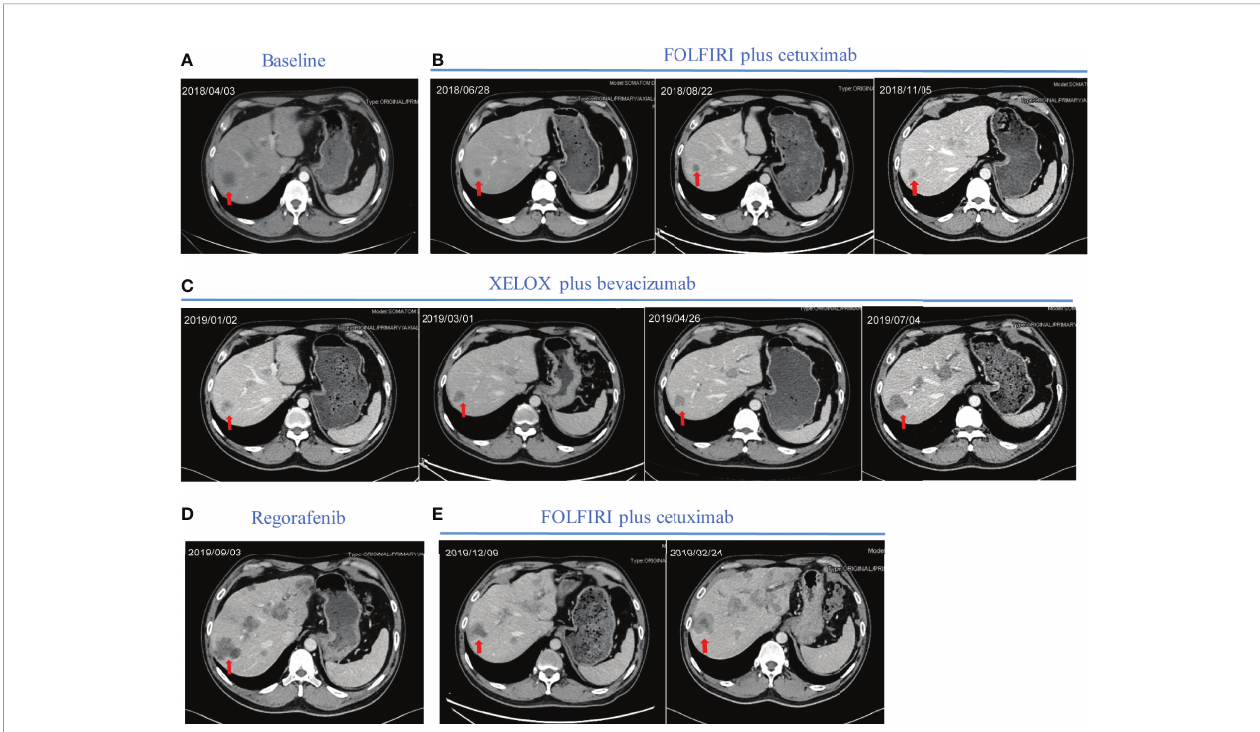
FIGURE 2 | Representative computed tomography (CT) images of liver lesions during treatment. (A) Before fi rst-line treatment, the representative CT image of the liver. (B) Regular CT was used to assess treatment ef fi cacy during fi rst-line treatment containing FOLFIRI plus cetuximab. (C) Regular revision CT was used to assess treatment ef fi cacy during second-line treatment containing XELOX plus bevacizumab. (D) CT image of liver lesions after two cycles of regorafenib. (E) CT images of liver lesions after two cycles and four cycles of rechallenging FOLFIRI plus cetuximab. Red arrows indicate typical liver lesions. CT computed tomography; FOLFIRI, chemotherapy regimen containing irinotecan and fl uorouracil; XELOX, chemotherapy regimen containing capecitabine and